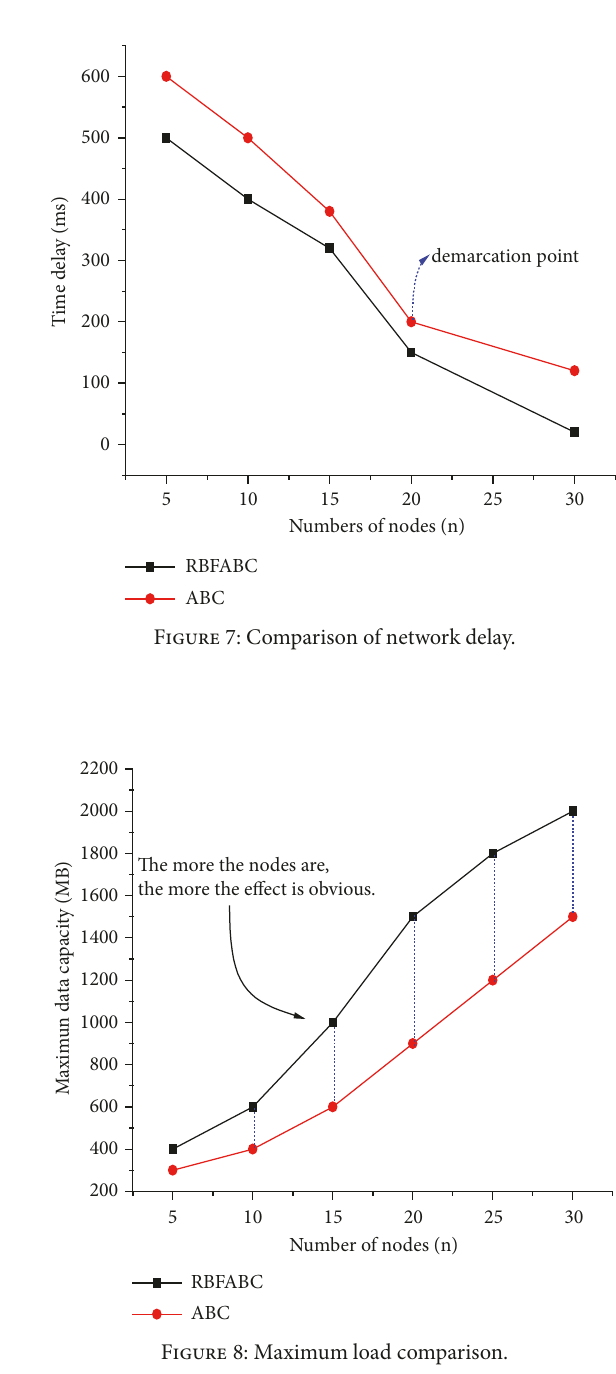
Figure 6: Comparison of speed trend.